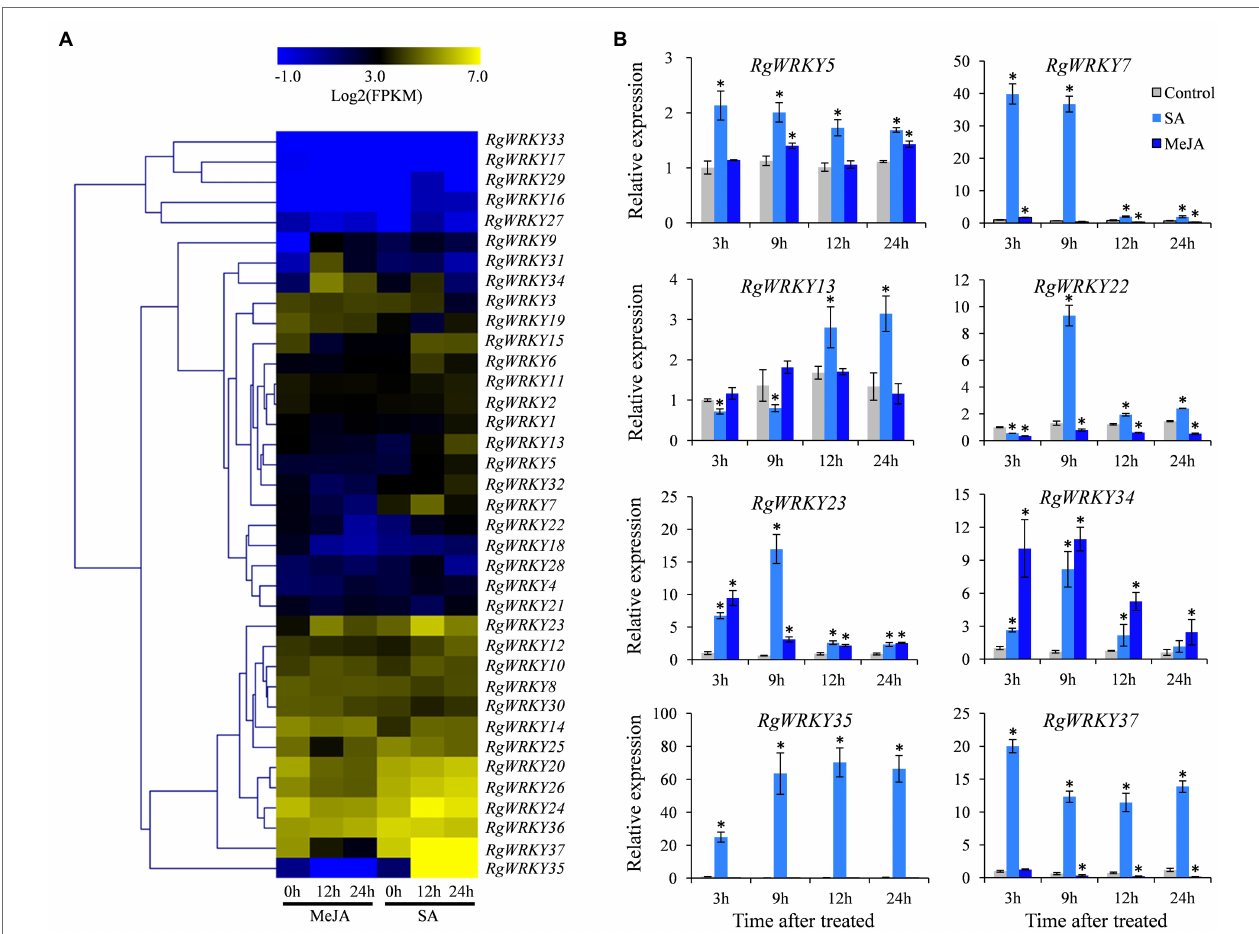
FIGURE 4 | Expression profiles of 37 WRKY genes in R. glutinosa hairy roots under salicylic acid (SA) and methyl jasmonate (MeJA) treatments. (A) Heat map representing expression dynamics of WRKY genes after SA and MeJA treatments. The expression value (FPKM) for unigenes was log2-transformed and scaled across each row, and heat map was generated by MultiExperiment Viewer (MeV). (B) Relative expression levels of eight WRKY genes in hairy roots after SA and MeJA treatments. These genes expression levels were all determined by quantitative real-time PCR (qRT-PCR). Vertical bars indicate the SD of three biological replicates. Asterisks indicate a significant difference at the p < 0.05 level. The same as